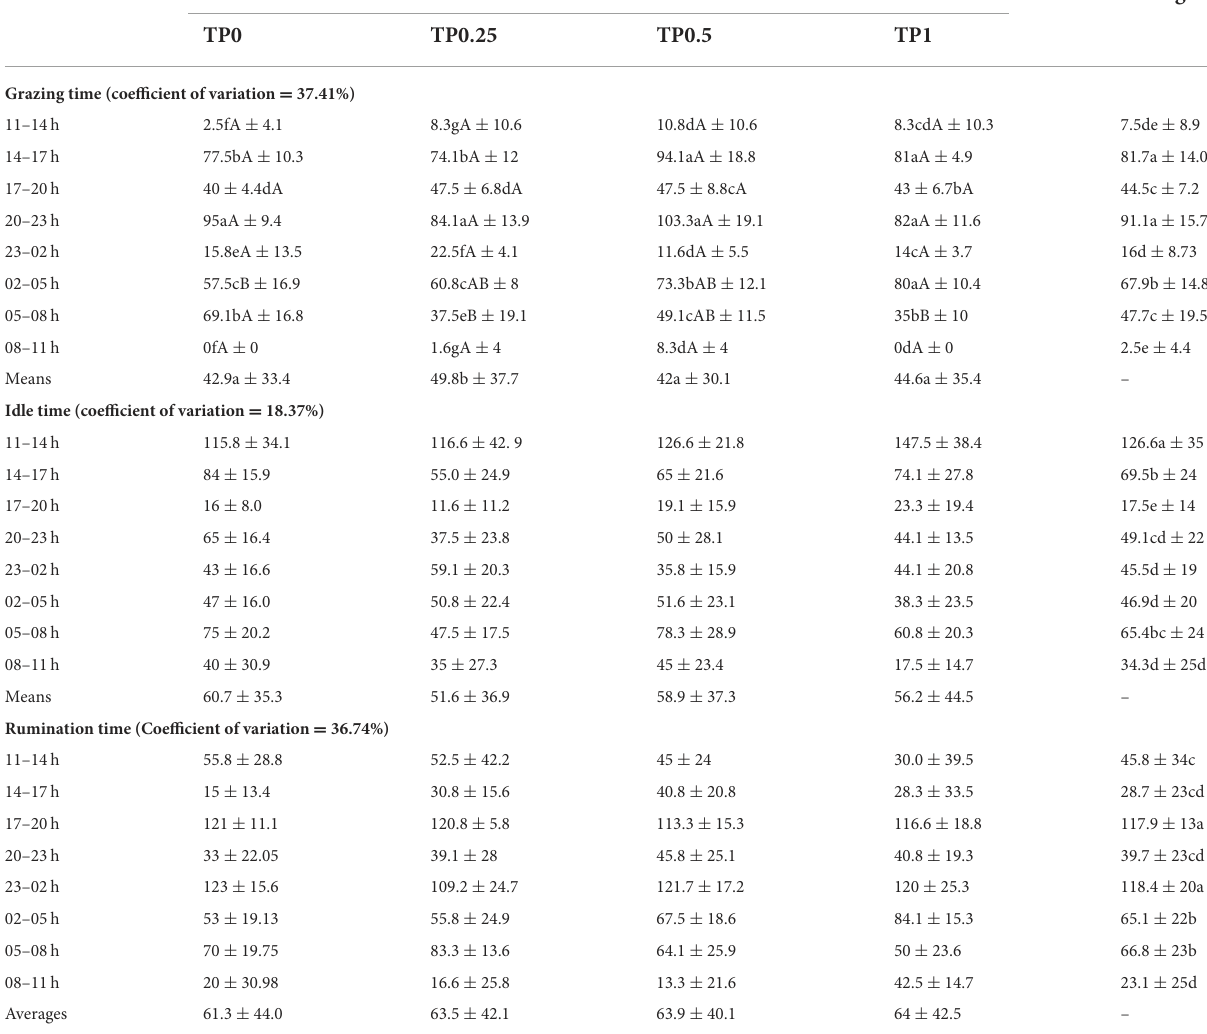
TABLE 5 Grazing, idleness, and ruminating time in female buffaloes supplemented with palm kernel cake during the less rainy season